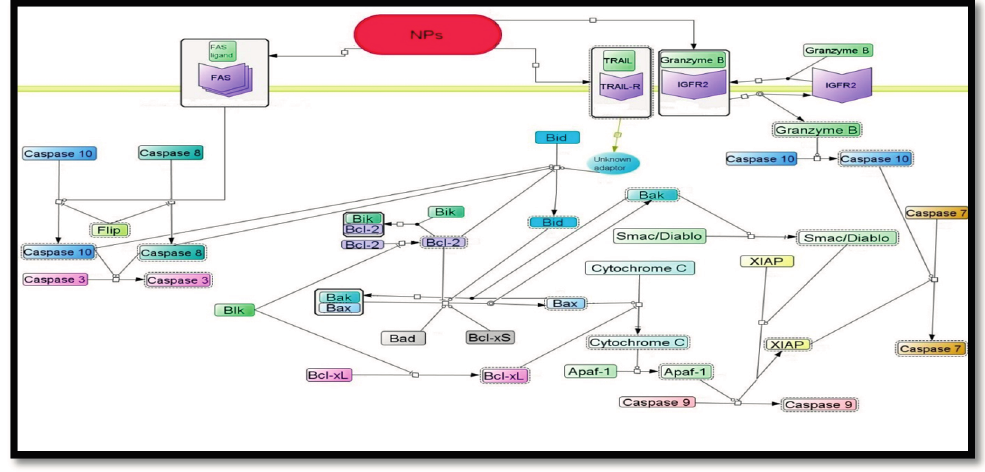
Figure 1. Proposed signaling pathways of nanoparticle induced apoptosis in cancerous cells. Apoptosis is induced by an apoptotic signal from NPs.